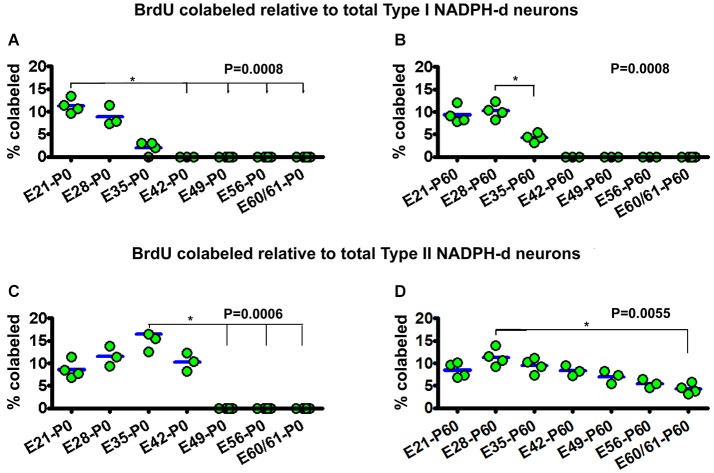
Dot graphs summarizing the percentages of bromodeoxyuridine (BrdU) labeled relative to the total population of type I (A,B) and type II (C,D) NADPH-d neurons among animal groups examined at postnatal day 0 (P0) (A,C) and P60 (B,D) following BrdU pulse-chasing at different embryonic (E) days (E21, E28, E35, E42, E49, E56 and E60/61). Each dot represents the mean from an individual animal. The mean is designated as zero for the animal if no BrdU colocalization in type I or type II NADPH-d neurons can be found by examination of multiple sections. BrdU colocalization in type I NADPH-d neurons can be detected in P0 and P60 animals received BrdU injections at E21, E28 and E35, variably from 2–11.3% group-wise (A,B). BrdU colocalization in type II NADPH-d neurons exists in P0 animal groups received BrdU injections at E21, E28, E35 and E42, variably from 8.6%–16.5% among individual groups. In P60 animals, BrdU colocalization in type II NADPH-d neurons is found in animal groups received BrdU injections at all prenatal time points (i.e., E21, E28, E35, E42, E49, E56 and E60/61), ranging from 4.8–11.3% among individual groups. P values represent comparison by Kruskal-Wallis test, with differences (per Dunn’s comparison test) between individual groups marked by lines and asterisks.